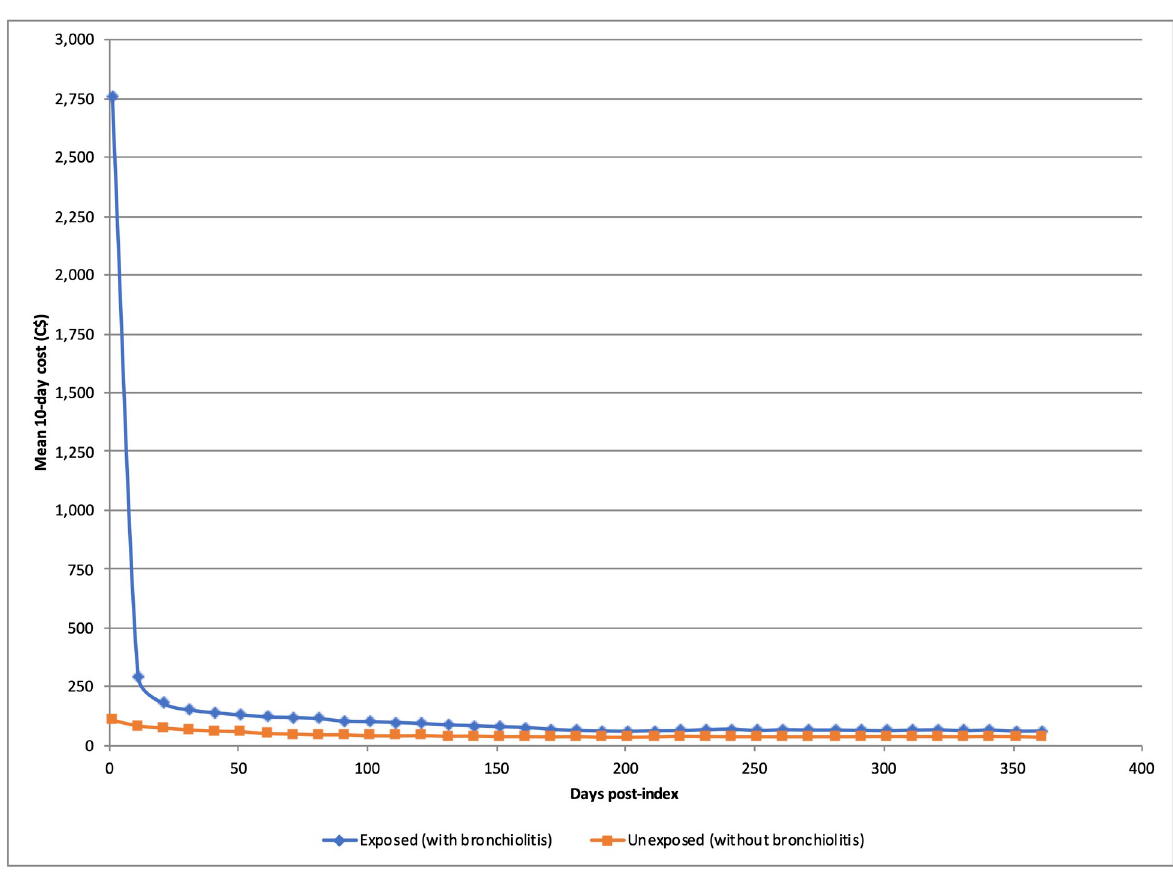
Fig 1. Mean healthcare costs up to 360 days post-index date (in 10-day intervals) among patients who survived 1 st year of life.